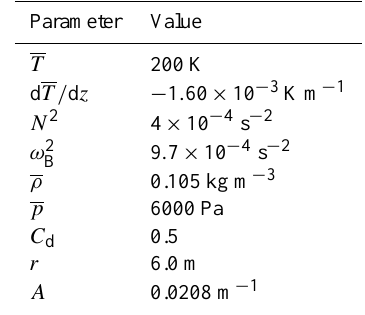
Table 1. Definition of terms used in the text. Symbol